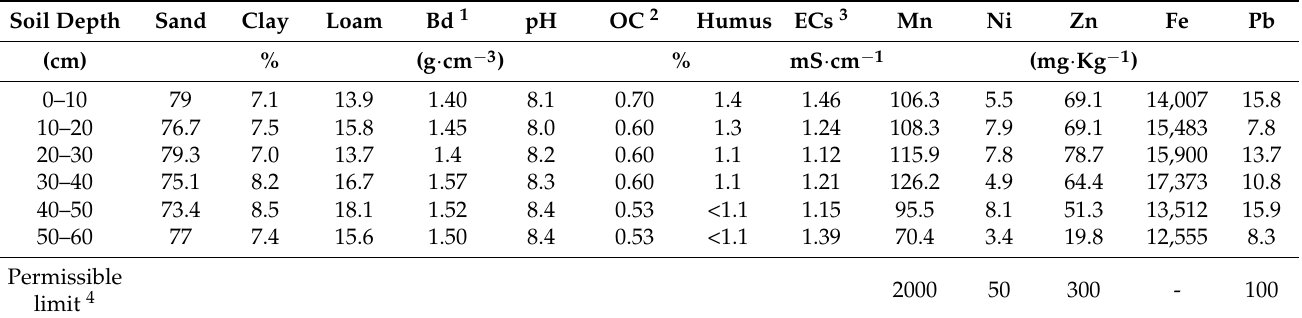
Table 1. Physical and chemical properties of the experimental